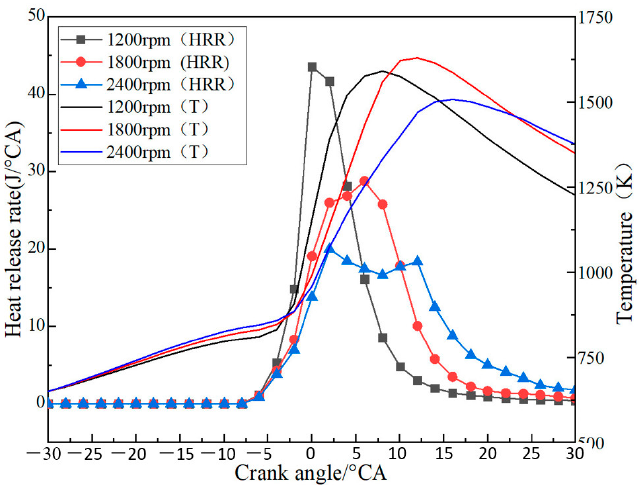
Figure 19. Variation of heat release rate with rotating speed. It can be seen from Figure 20, the rising range of fuel mass flow rate basically coincides with different engine loads. The combustion heat release rate in the cylinder increases with the increase of engine load. When the engine load is increased from 25% to 100%, the HRR is increased by about four times. According to the analysis, with the increase of load, the mass of the fuel-air mixture formed during the ignition delay period increases, which leads to the proportion of premixed combustion in the whole combustion process increasing, and the diffusion combustion gradually weakening.